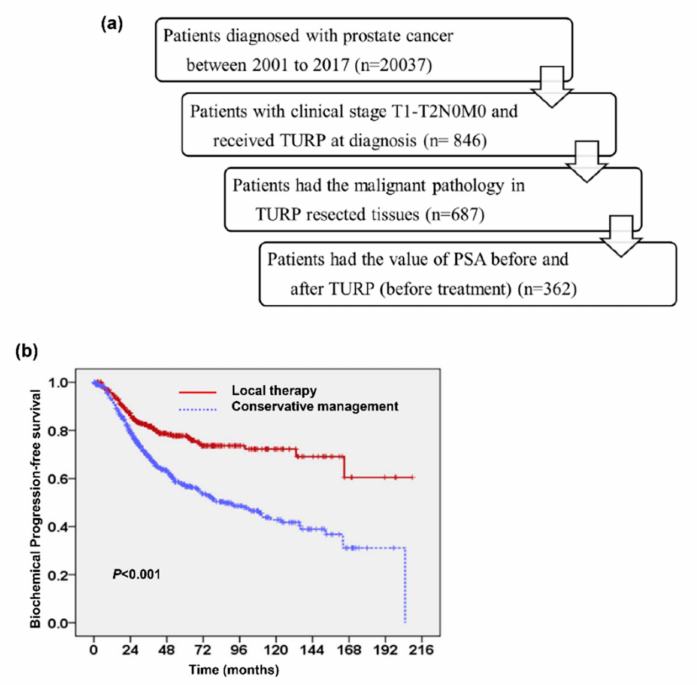
Figure 1. Survival in patients with early stage prostate cancer. We enrolled the patients with clinical stage T1–T2N0M0 prostate cancer who underwent transurethral resection of the prostate (TURP) into our present study. The study flow chart was presented in ( a ). Additional, Kaplan–Meier survival curves of progression-free survival (PFS) stratified by the addition of local therapy ( b ).